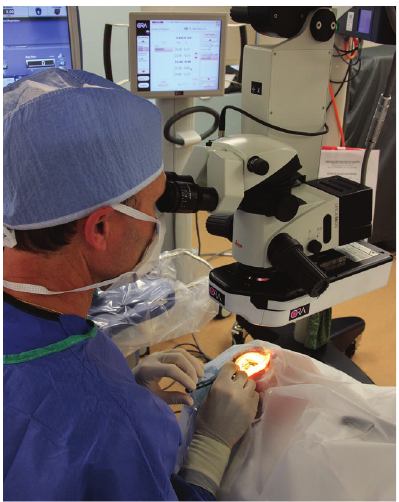
Figure 2: The ORA device attached to the operating